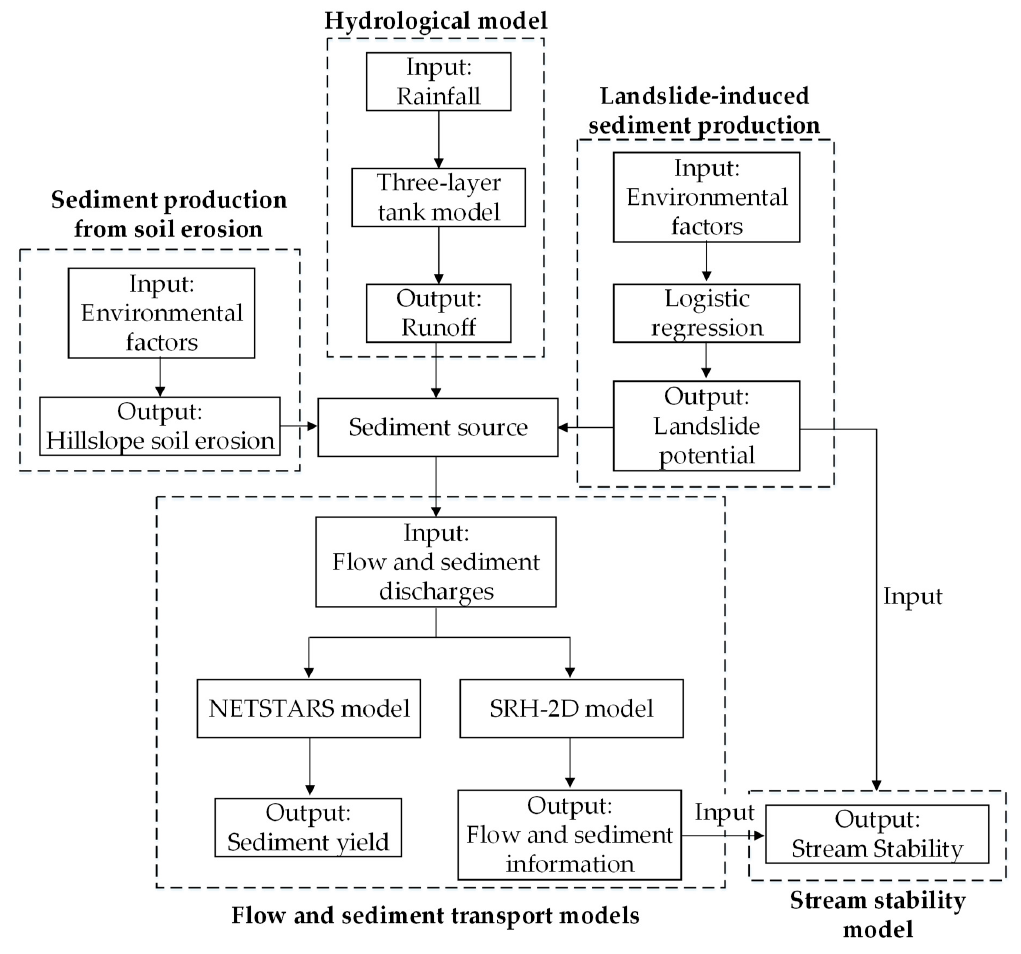
Figure 2. Framework for the proposed integrated model.